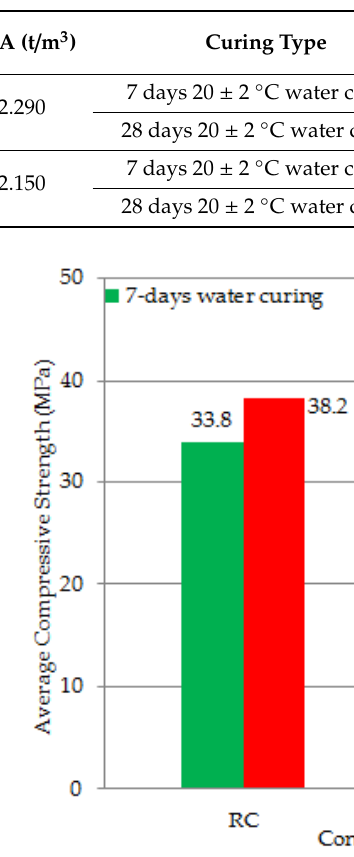
Table 36. The average compressive and bending strength test results of concrete types.